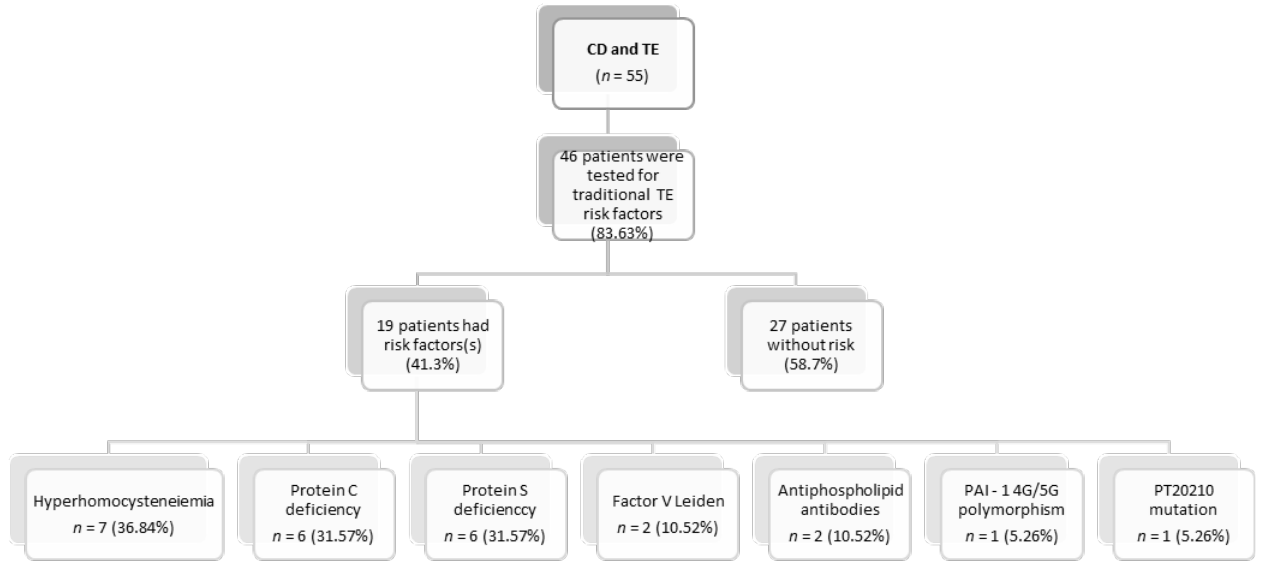
Figure 2. Thrombophilia in patients with celiac disease and thrombotic events.